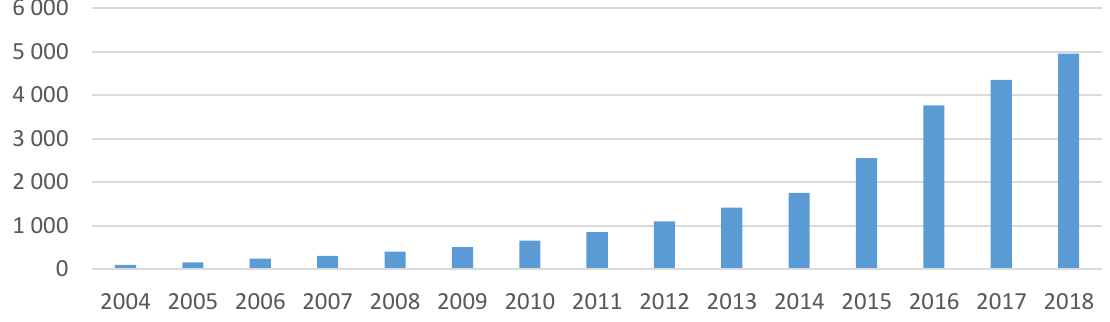
Figure 1. Number of open-end funds in the Chinese mutual fund industry